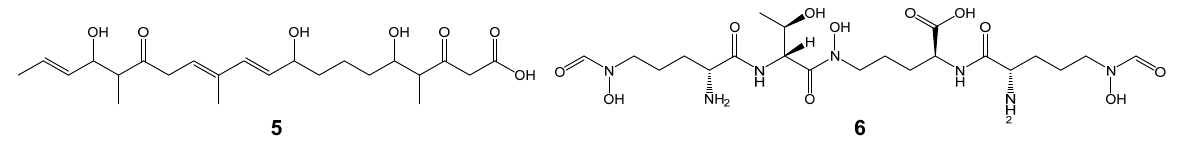
Table 3. PKS and NRPS gene clusters in the genomes of S. olivaceus N11-26, DC10-5 and NRRL B- 3009 T